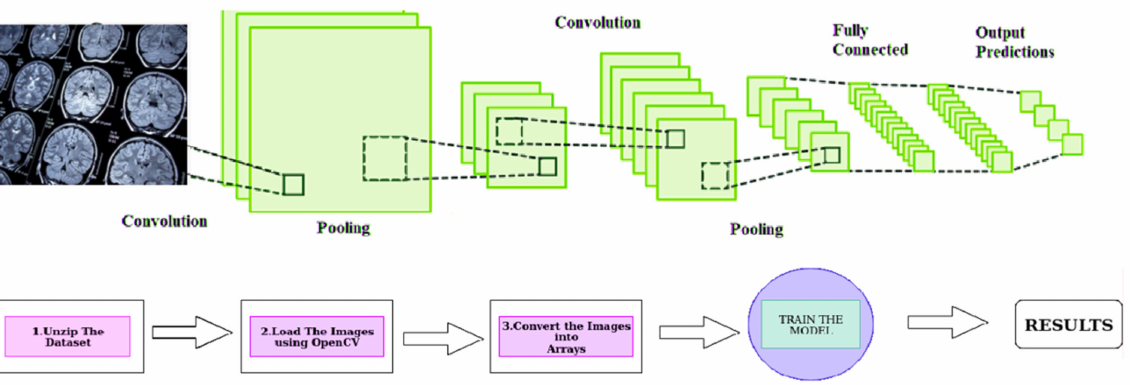
Figure 1. Deep Learning Approach for Brain Tumor Identification using Convolutional Neural